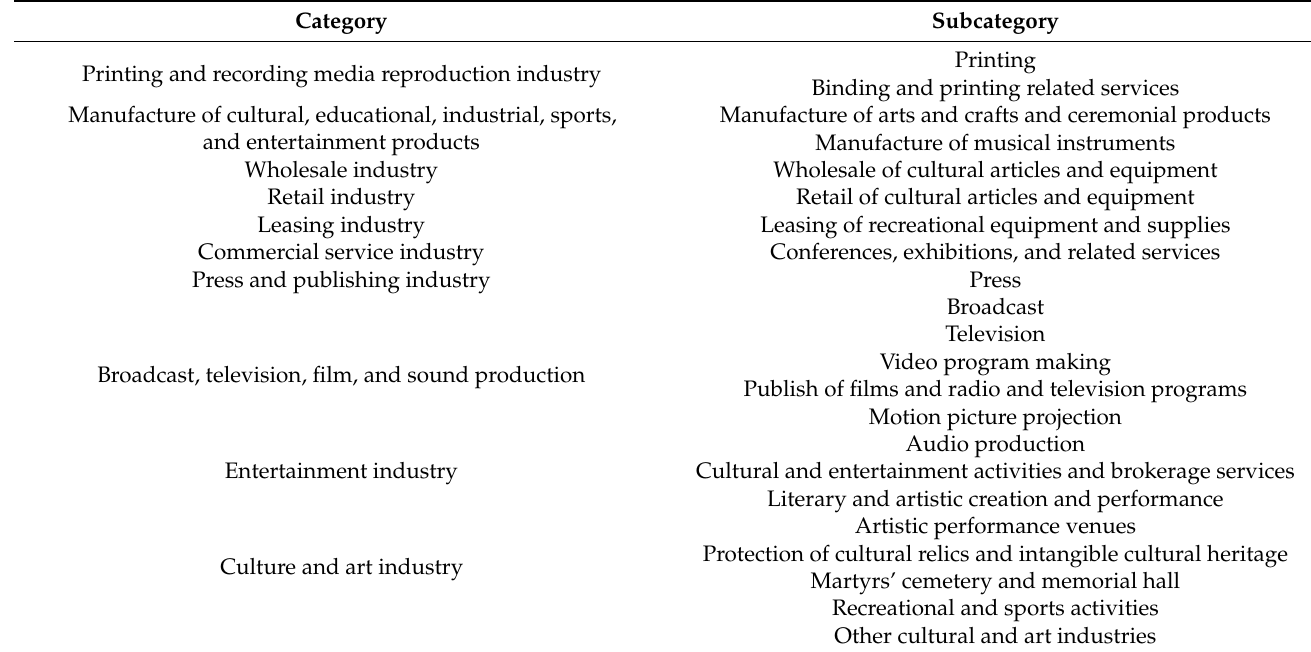
Table 4. The statistical caliber of cultural